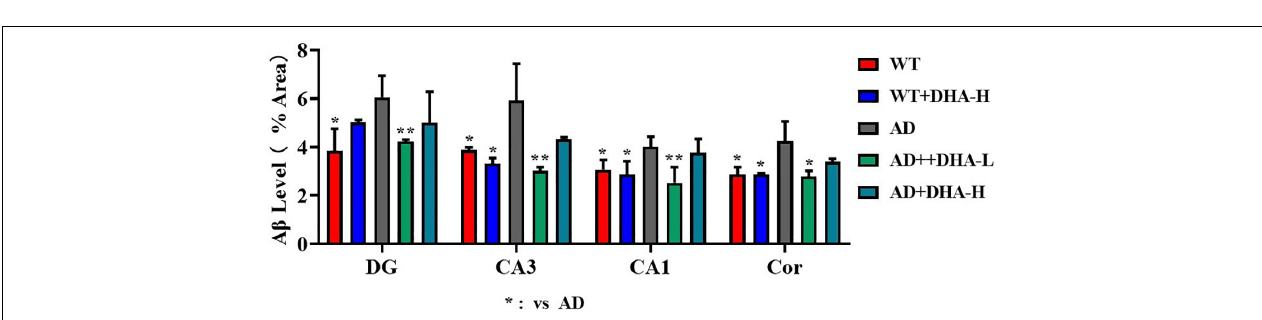
FIGURE 10 | Effects of DHA treatment on NFT level in the brain in 2 × Tg AD mice. * p < 0.05, ** p < 0.01. Error bars represent mean ± S.E.M. ( n = 6).